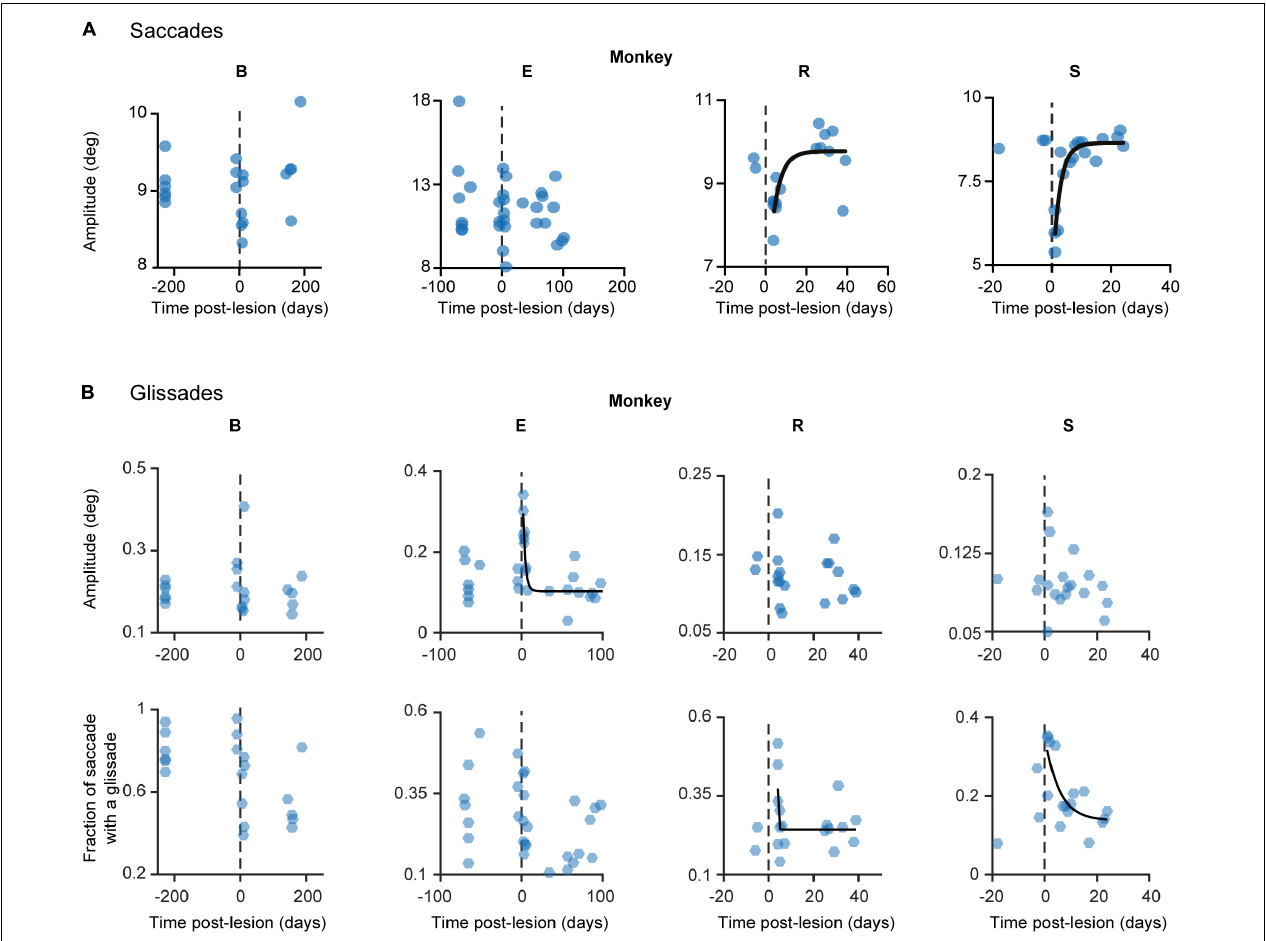
FIGURE 5 | Development of lesion phenotypes over time. (A) Saccade amplitude per monkey plotted over time. Blue dots represent average saccade amplitude per experimental day including all directions pooled together, black fits represents exponential fit (f(x) = a ∗ exp( − x/b) + c). (B) Same as in (A) but the hexagons indicate glissade amplitude and fraction. See Supplementary Table 3 for p -values and coefficient of determination. Fraction is defined as the number of saccades containing a glissadic overshoot. Only overshooting glissades were used for this analysis. Labels “B,” “E,” “R,” and “S” denote each of the four